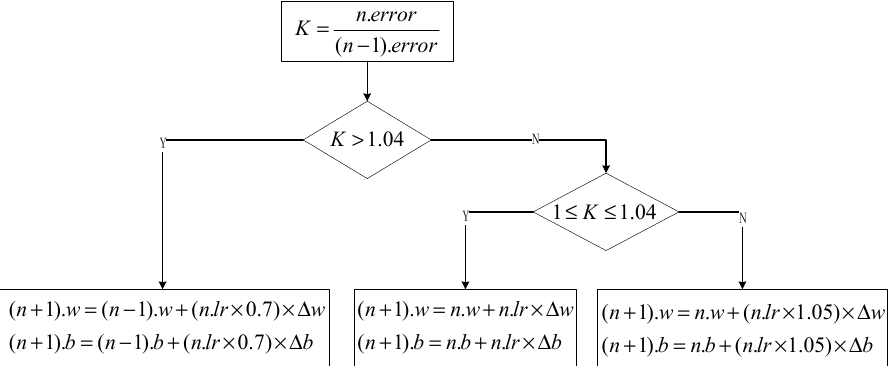
Figure 2. Flowchart of the adaptive adjustment of the learning rate.